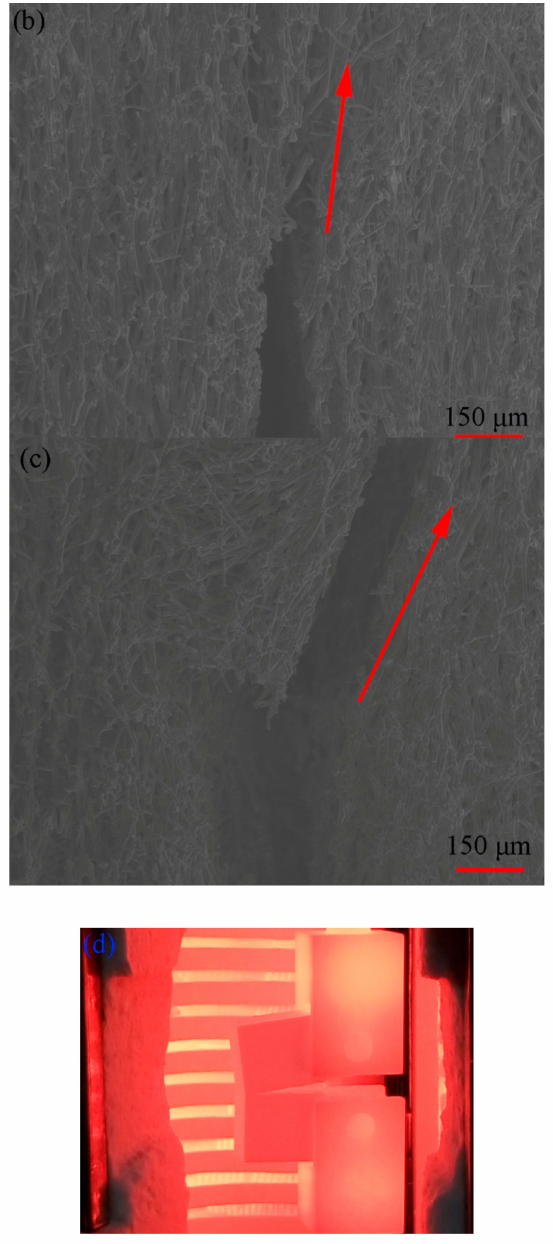
Figure 5. ( a ) The fracture toughness J C of the CT specimens at various temperatures, with crack length – to – width ratios of 0.4 and 0.5, respectively. The crack tip of the specimen (a / W = 0.4) at ( b ) 299 K and ( c ) 1123 K after testing. The red arrows denote the direction of the crack propagation. ( d ) An image of a CT specimen tested in the